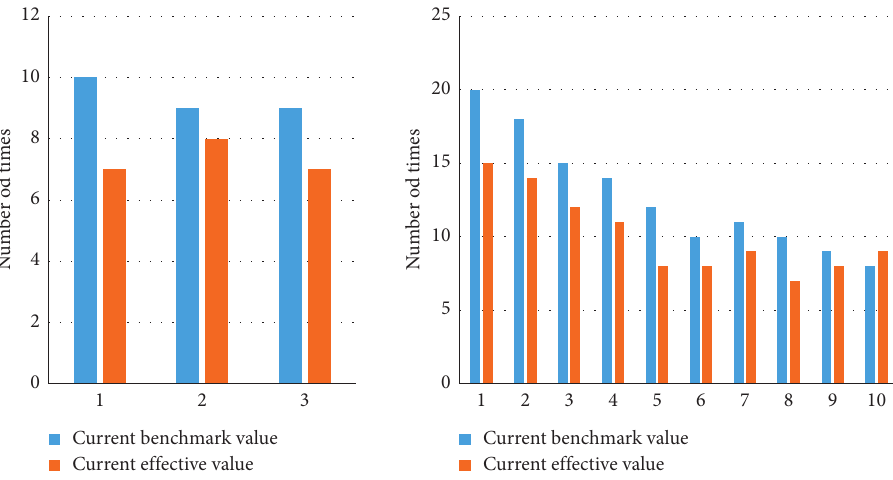
Figure 5: Benchmark value comparison chart.